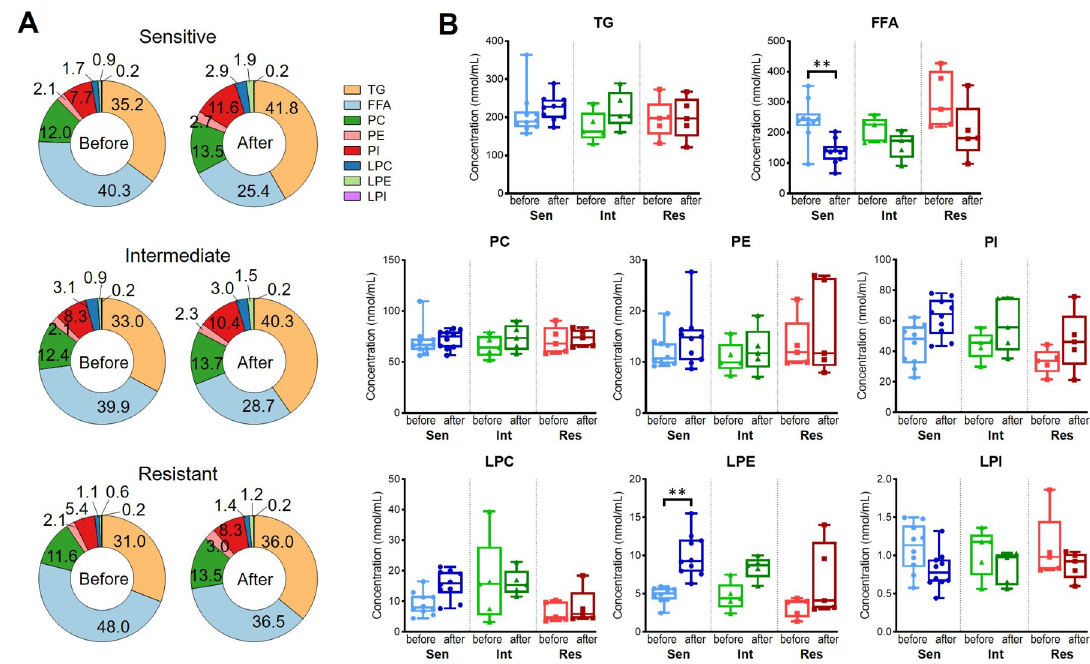
Fig 1. Percentage (A) and concentration (B) of every lipid class in the KD serum before and after treatment among IVIG-sensitive, -intermediate, and -resistant groups. ** P < 0.01. https://doi.org/10.1371/journal.pone.0283710.g001 capabilities, with AUC not less than 0.80 and P -value no more than 0.05 for all. The best cut- off, together with the corresponding specificity and sensitivity for each lipid species, was calcu- lated, of which PC32:1 showed the most satisfied diagnostic capacity (best cut-off: 0.5243, with the specificity of 0.80 and sensitivity as 1.00). The results suggest that these lipids may predict IVIG responsiveness in KD.